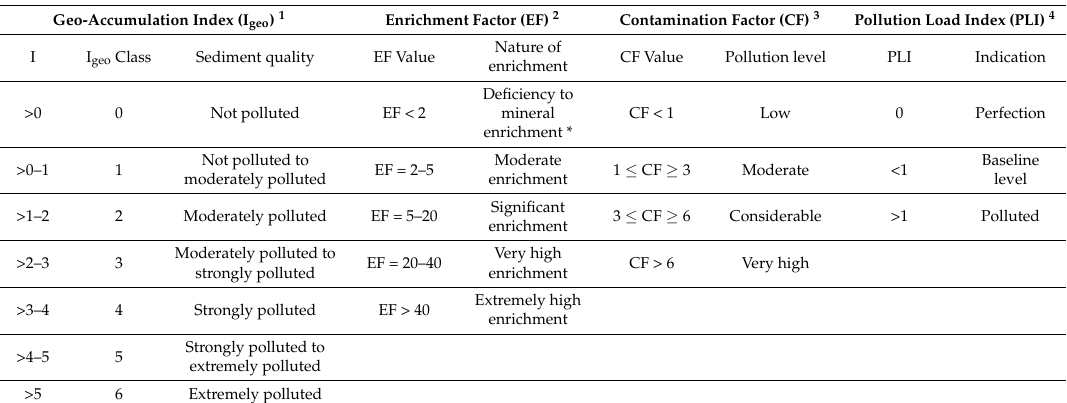
Table 2. Sediment quality classification for multiple indices to assess heavy